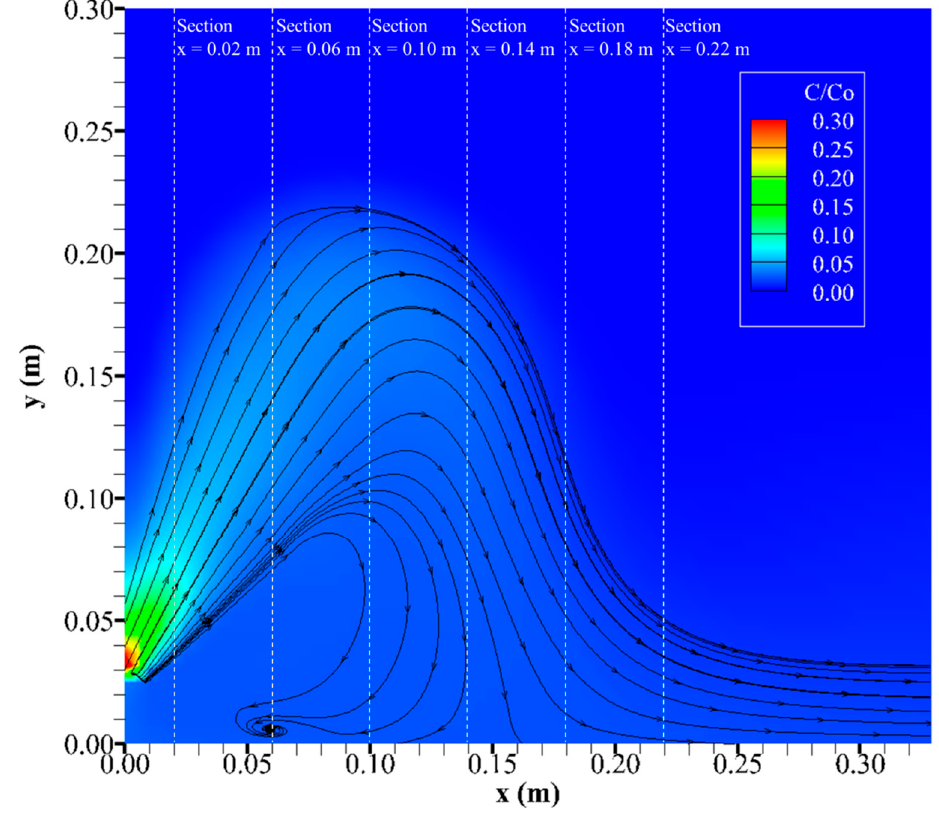
Figure 2. Concentration fields at the central plane; Case C1, F = 62.9, and s /( d · F ) = 0.94.